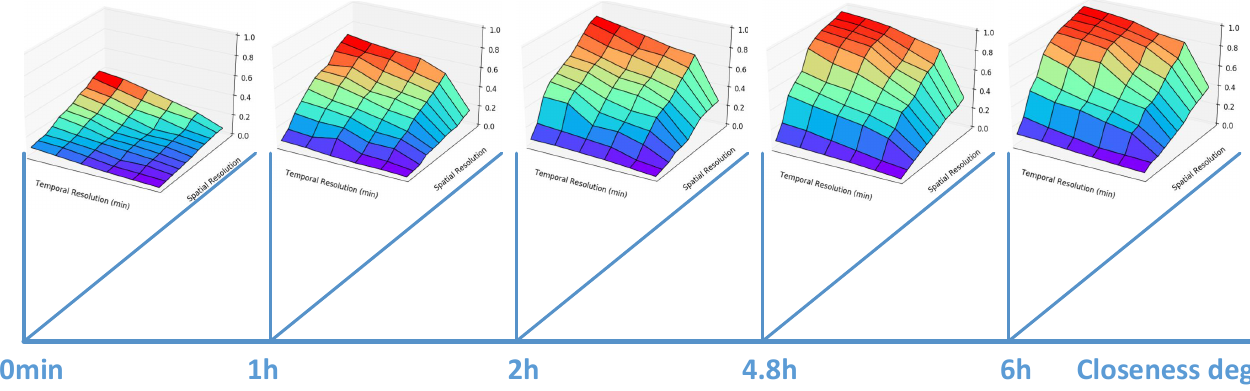
Figure 6. The Uniqueness of Traces with different closeness degree in Shanghai. Note that the observation points count N takes 4.